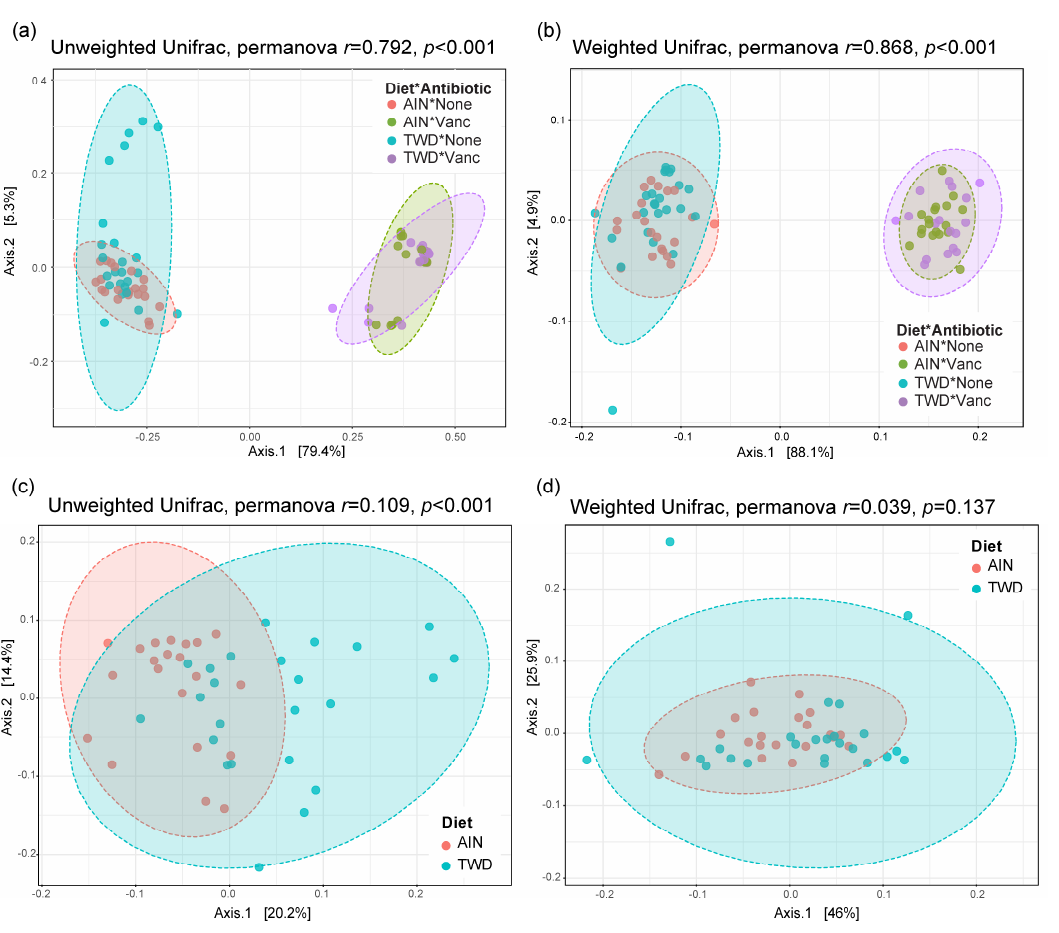
Figure 9. PCoA plots depicting beta diversity of fecal microbiomes. ( a , b ) Unweighted ( a ) and weighted ( b ) unifrac distances for all experimental groups. ( c , d ) Unweighted ( c ) and weighted ( d ) unifrac distances for AIN and TWD groups provided water with no antibiotic. The first two components and the variation attributed are shown, and permanova r and p values are provided for each plot. Abbreviations: PCoA, principal coordinate analysis; AIN, the AIN93G diet; TWD, the total Western diet; Ab,